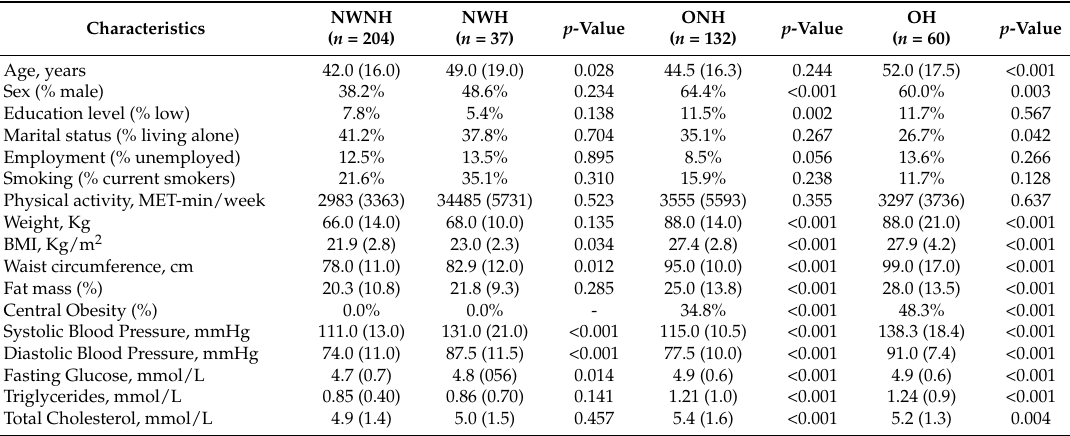
Table 1. Characteristics of the study